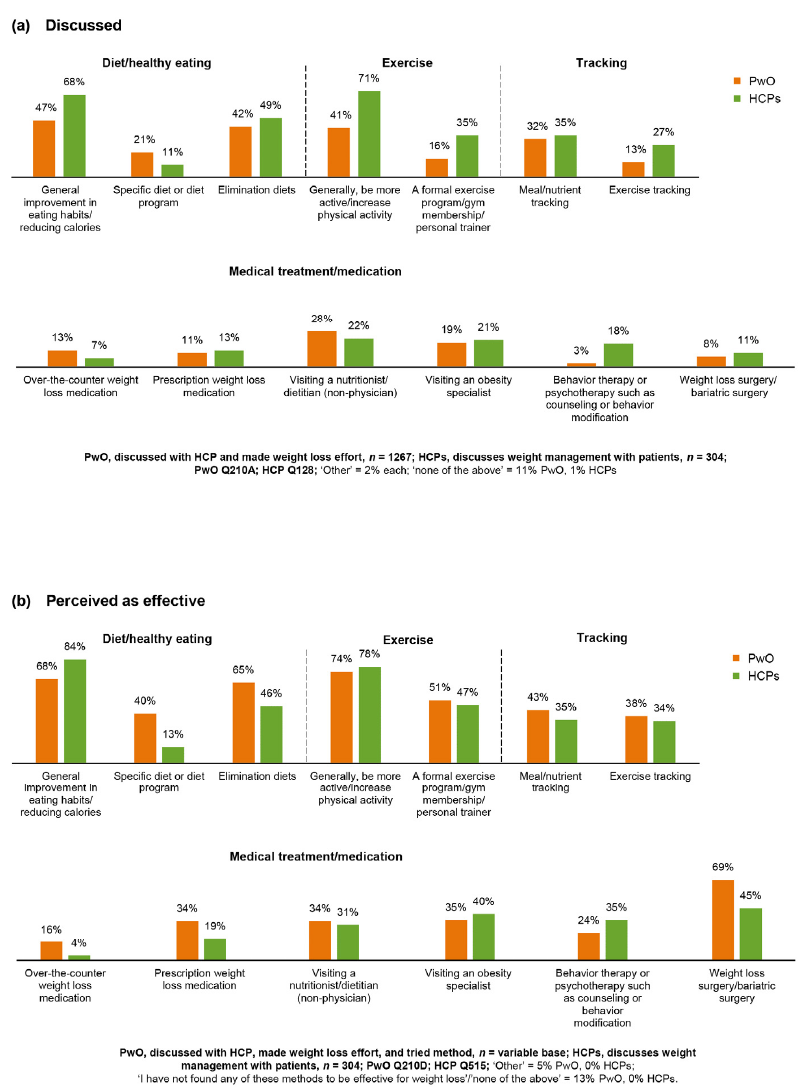
Figure 5. Weight management methods discussed / recommended and perceived e ff ectiveness. ( a ) Weight management methods discussed with an HCP (reported by PwO) and recommended by HCPs; ( b ) weight management methods perceived as e ff ective by HCPs or PwO. PwO = orange; HCPs = green. HCP, healthcare professional; PwO, people with obesity.